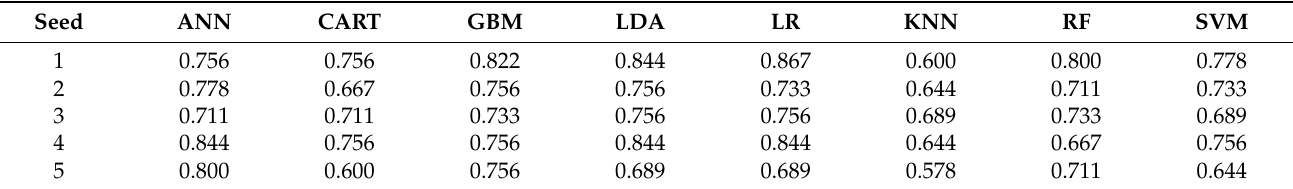
Table 3. Different models AUC results for seed values from 1 to 5.